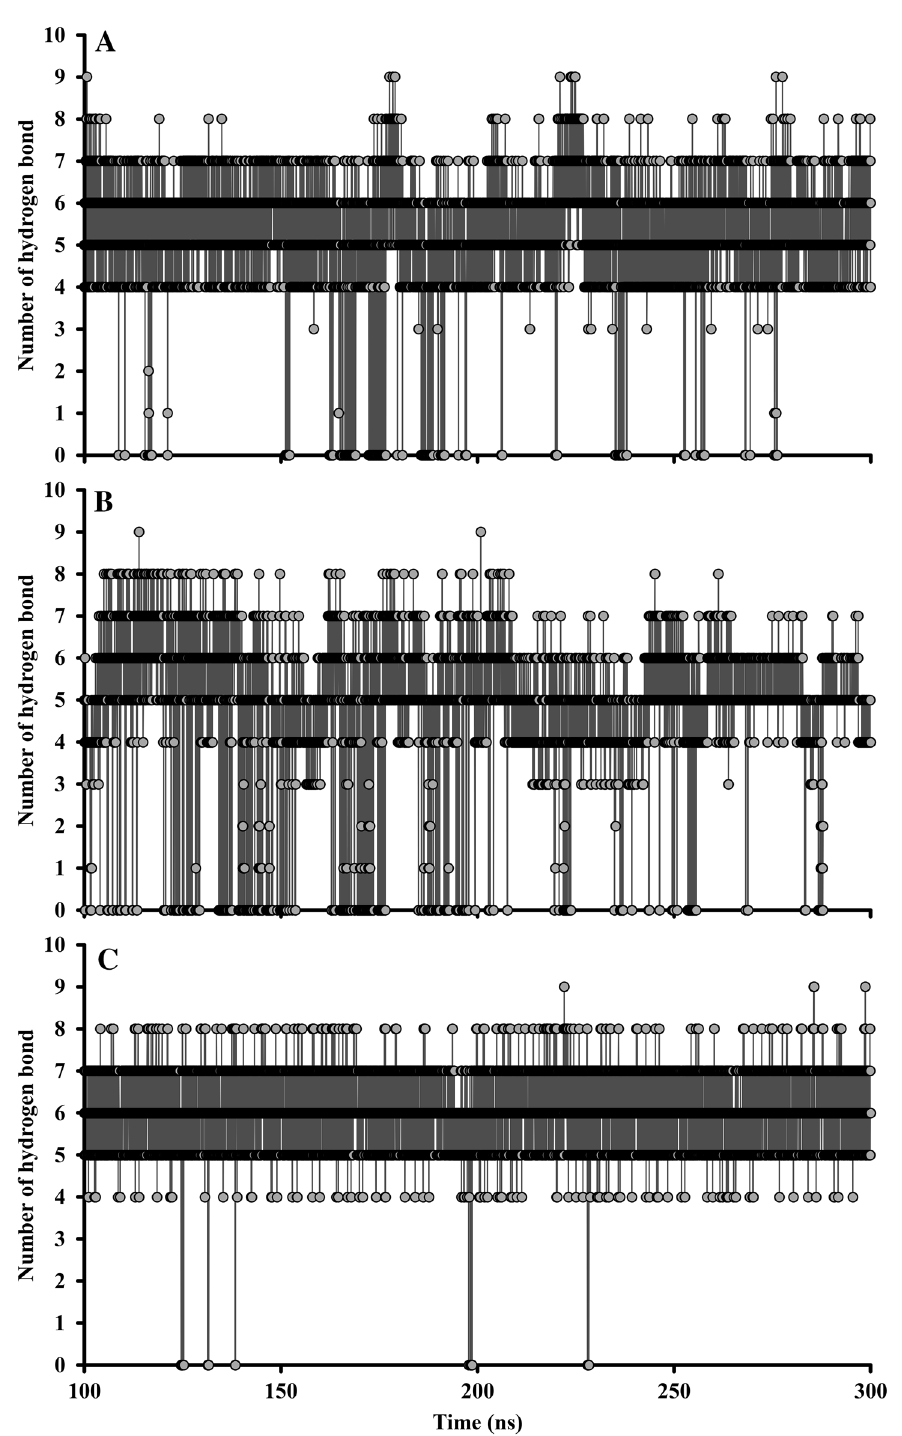
Figure 4. Hydrogen bond analysis of bound SRCR5 forms with three natural compounds: ( A ) SRCR5-brazilin, ( B ) SRCR5-catechin, and ( C ) SRCR5-epicatechin